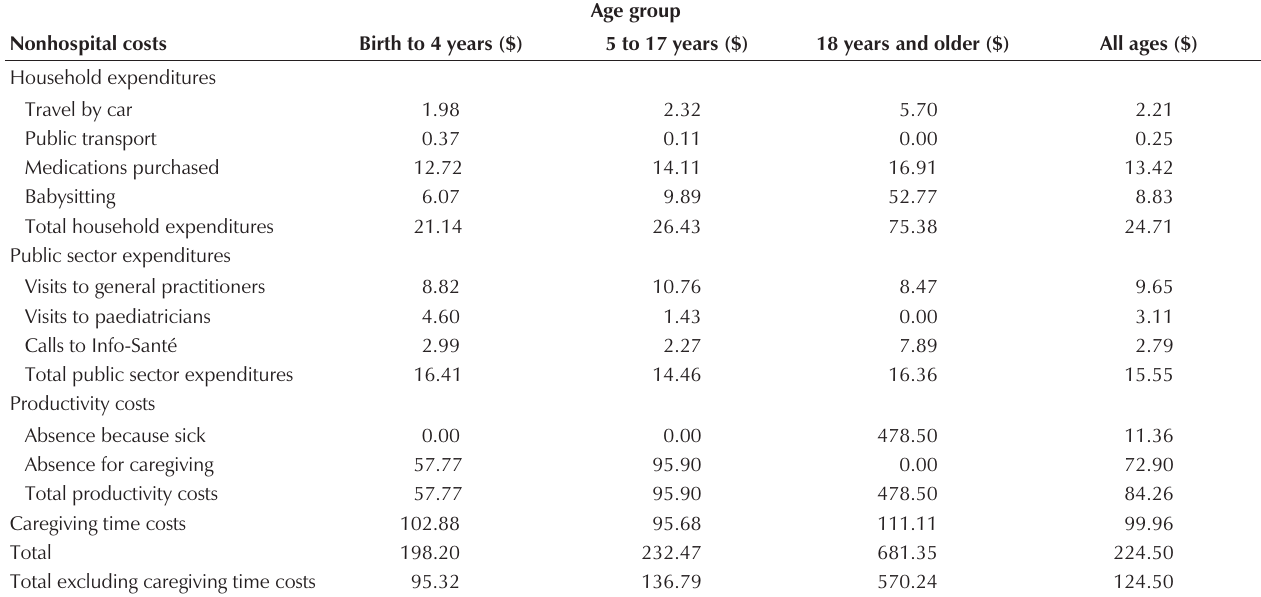
Average nonhospital costs for a case of chickenpox by age group in Quebec from September 1, 1997 to August 31,